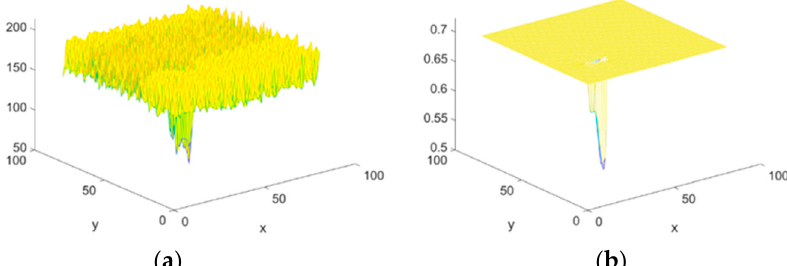
Figure 5. Detection effect of LGM. ( a ) Mesh diagram of fabric defect image; ( b ) Mesh diagram of smoothed fabric defect image.